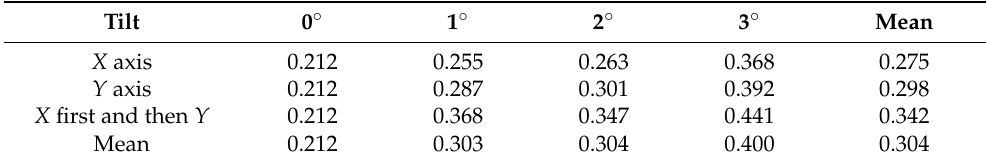
Table 5. Tower tilt calculation 1 .